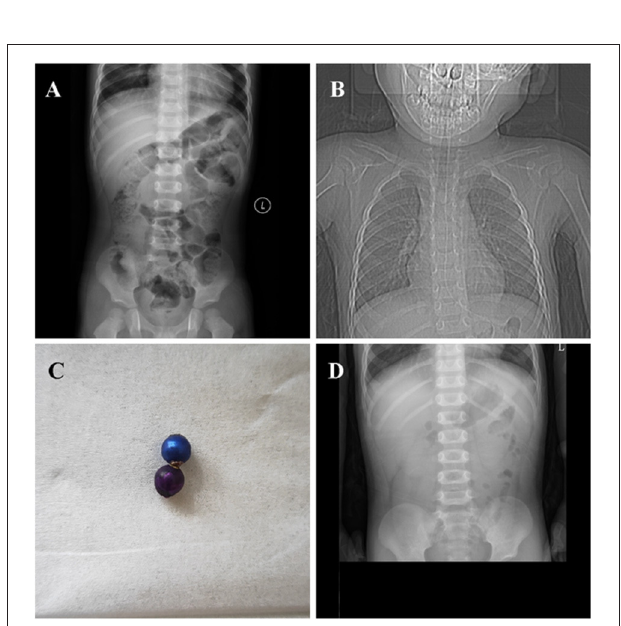
FIGURE 2 | Abdominal DR indicated no obvious abnormality at 6h post-operatively (A) . Chest DR re-examination indicated that the foreign body shadow had disappeared before the planned second operation (B) . The blue and purple magnetic beads were magnetically attracted (C) . Abdominal DR re-examination indicated no obvious, remaining, foreign body shadow after the second foreign body had been expelled (D)